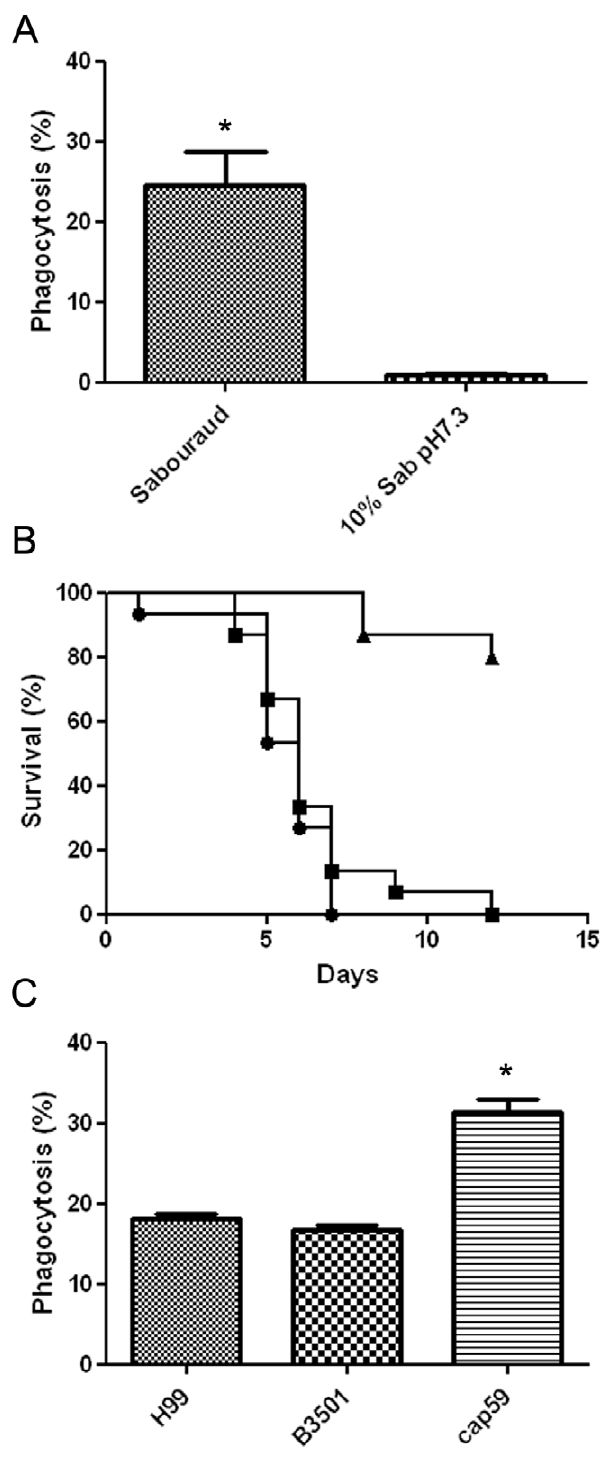
Figure 3. Role of the capsule on phagocytosis by haemocytes. A ) Cells with small (grown in Sabouraud) and large capsule (incubated in 10% Sabouraud buffered with 50 mM MOPS pH 7.3) were stained with Calcofluor and used to infect caterpillars. Bars show the average phagocytosis at 2 h. p , 0.05 is indicated with an asterisk. The experiment was repeated twice in triplicates. B ) Survival curves of G. mellonella infected with 10 4 cells of C. neoformans grown in Sabouraud broth and in 10% Sabouraud diluted in MOPS pH 7.3. C ) In vivo phagocytosis using H99, B3501 and cap59 (C356) strains was performed as described in section A and quantified after 2 h of infection. Bars